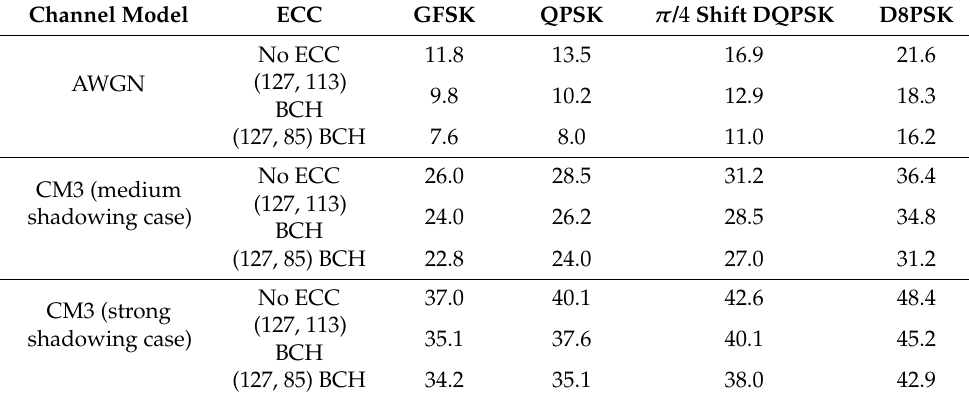
Table 9. E s / N 0 (dB) satisfying PER ≤ 10 − 3